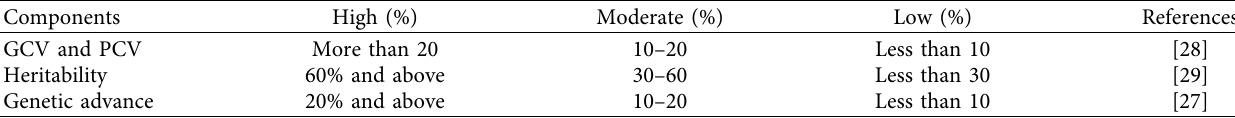
Table 2: Limits used for categorizing the magnitudes of diferent